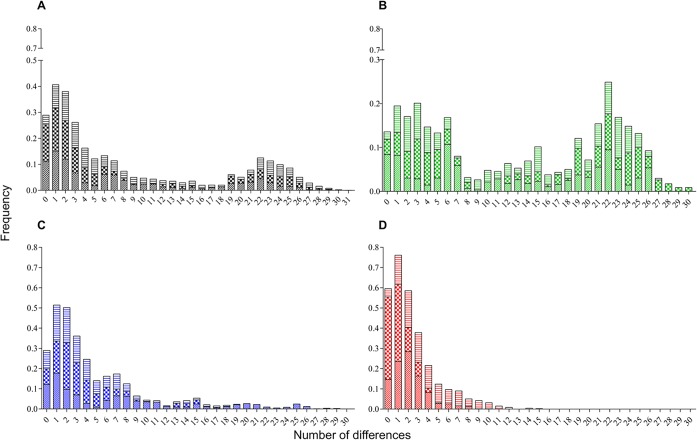
Nucleotide mismatch distribution of combined COI-ND4 genes in Ae. aegypti mosquitoes of Colombia.Histograms of mismatch distribution for (A) total haplotypes analyzed and haplotypes within each city of BE (B), RI (C) and VI (D). Color indicates collection origin: BE (green), RI (blue) and VI (red); the cross, bold crossbars and horizontal lines represent the samplings A, B, and C, respectively (see Table 1 for details).